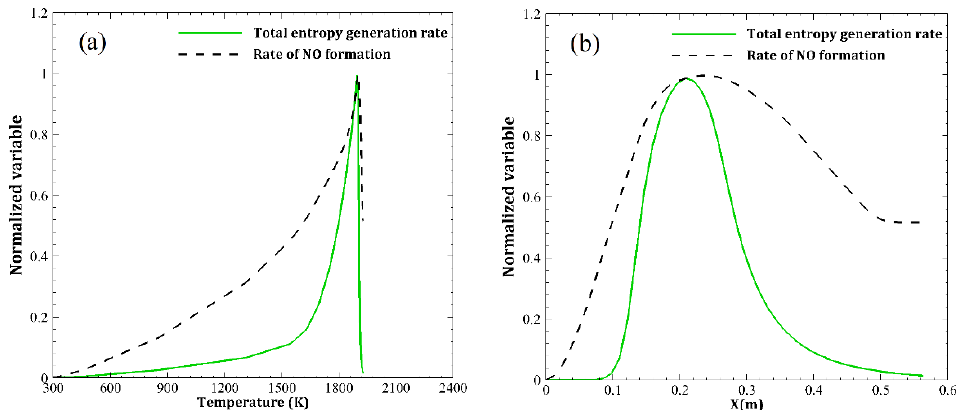
Figure 12. Normalized variable of total entropy generation rate and NO formation rate: ( a ) mean temperature and ( b ) along center line (Y = Z = 0).